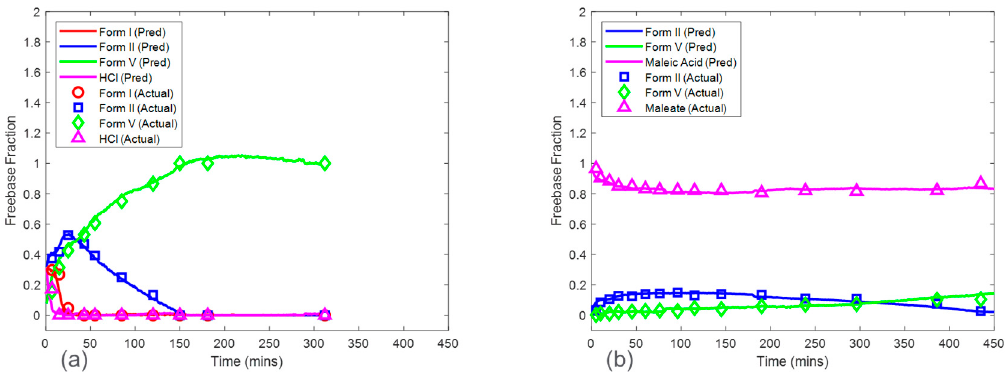
Figure 8. Baseline model predictions on test run condition of 16.7 mg/mL for the HCl salt experiment ( a ) and the maleate salt experiment ( b ). Note the relative standard deviation of XRPD reference values was approximately 4%.